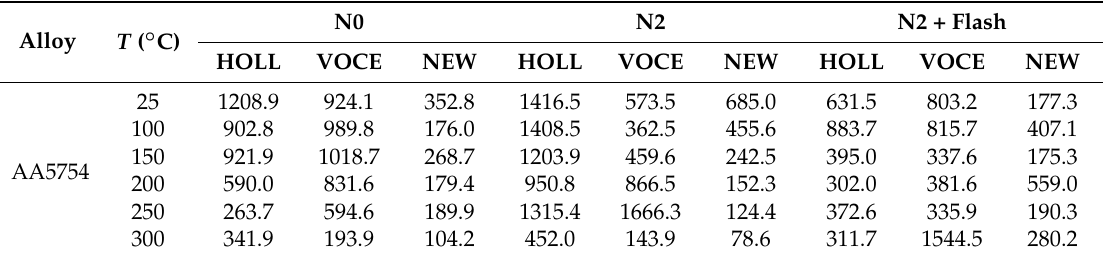
Table 16. Error of each flow rule obtained for AA5754 in relation to the experimental curve (N).